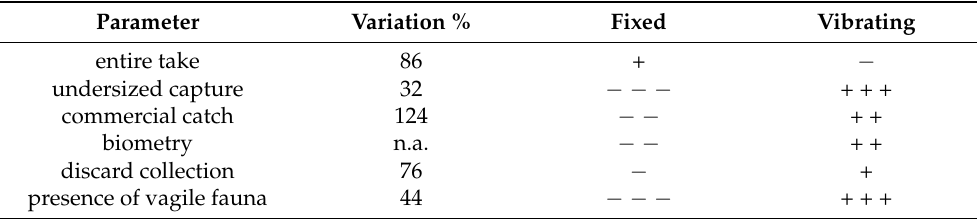
Table 6. Synopsis of the advantages of traditional vs. innovative